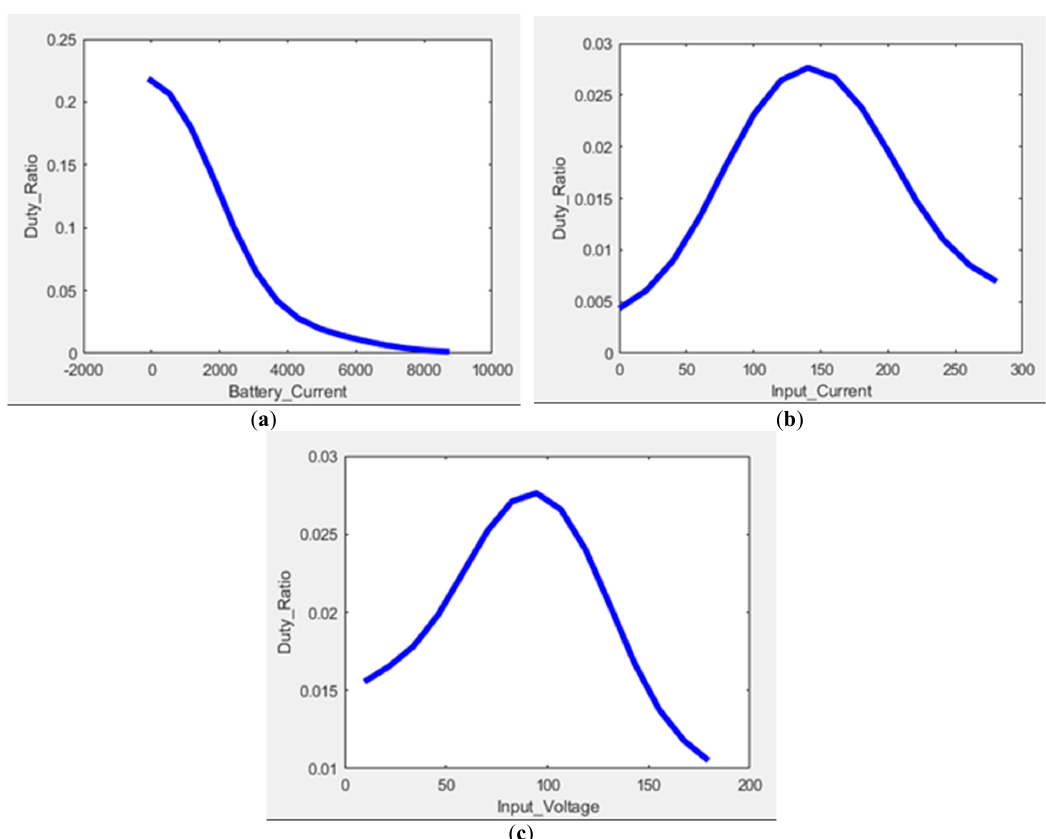
Figure 40. Correlation between the variables ( a ) duty ratio and battery current, ( b ) duty ratio and